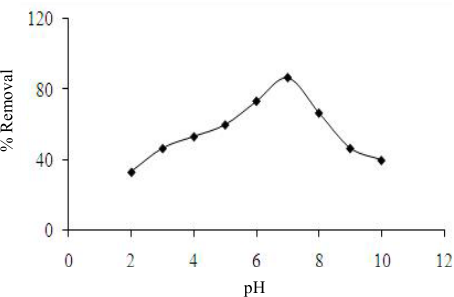
Figure 3. Effect of pH on the removal of MG by